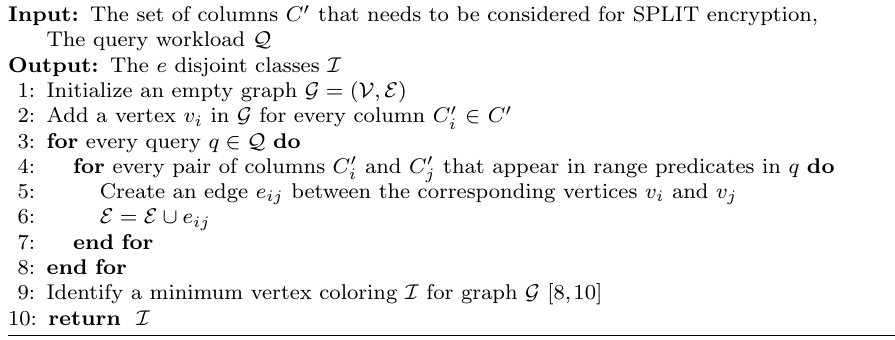
Algorithm 2 Minimum Number of Disjoint